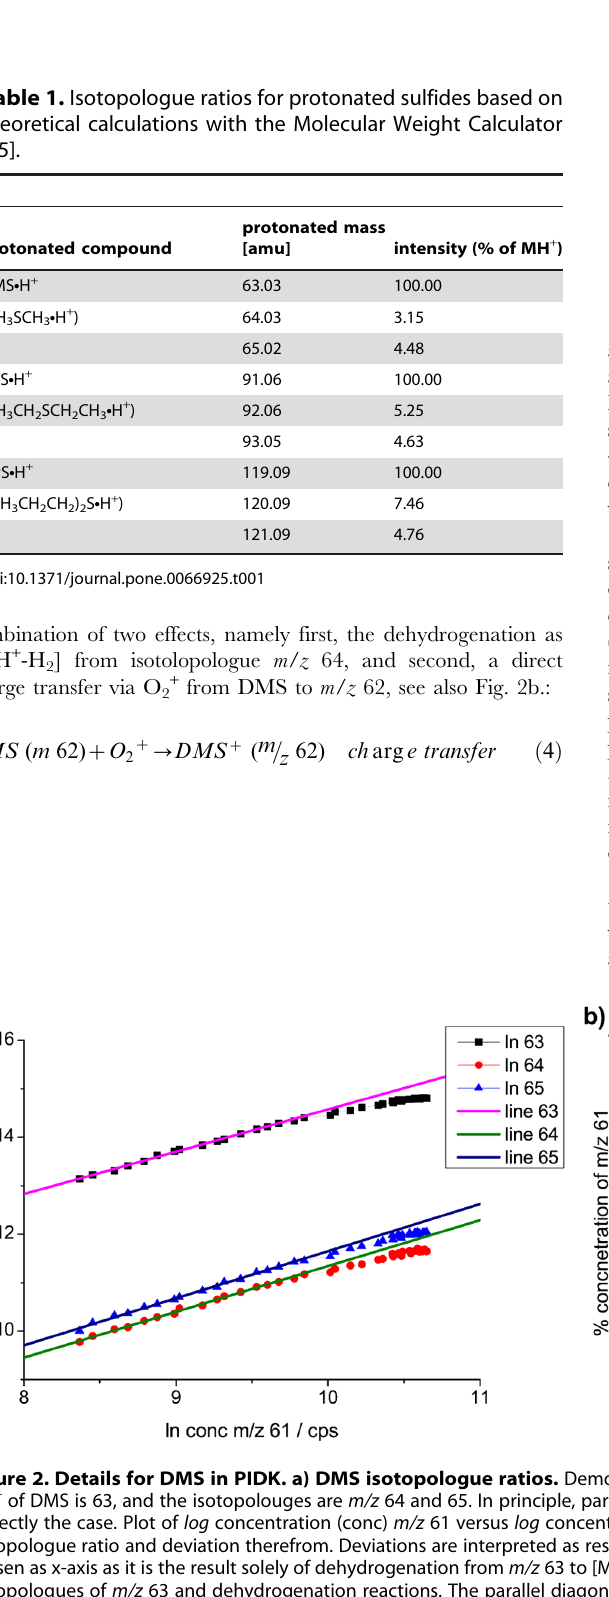
N ). dehyd=dehydration.